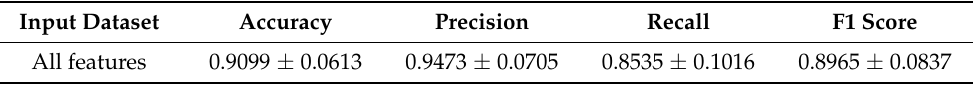
Table 5. Performance metrics of the optimized SVM classifier using all available features as